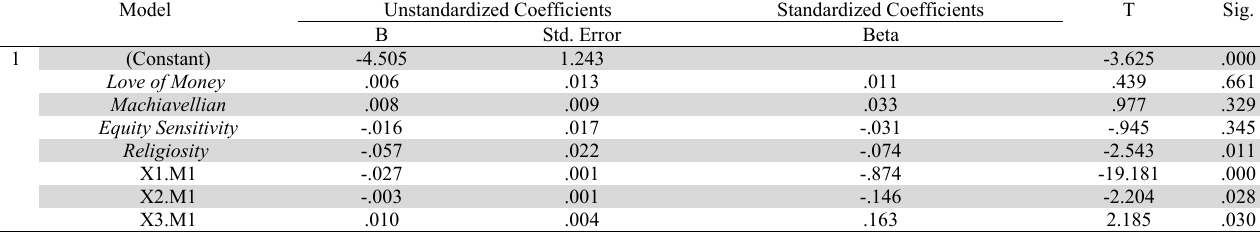
Results of Moderation Analysis of Intrinsic Religiosity